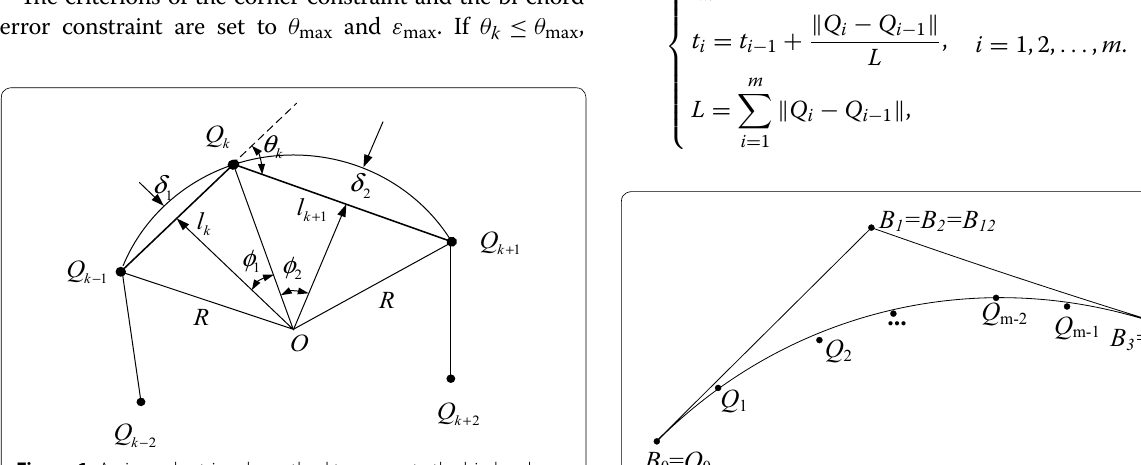
Figure 1 An isosceles triangle method to compute the bi-chord errors Figure 2 Get Bézier curve by the least square fitting